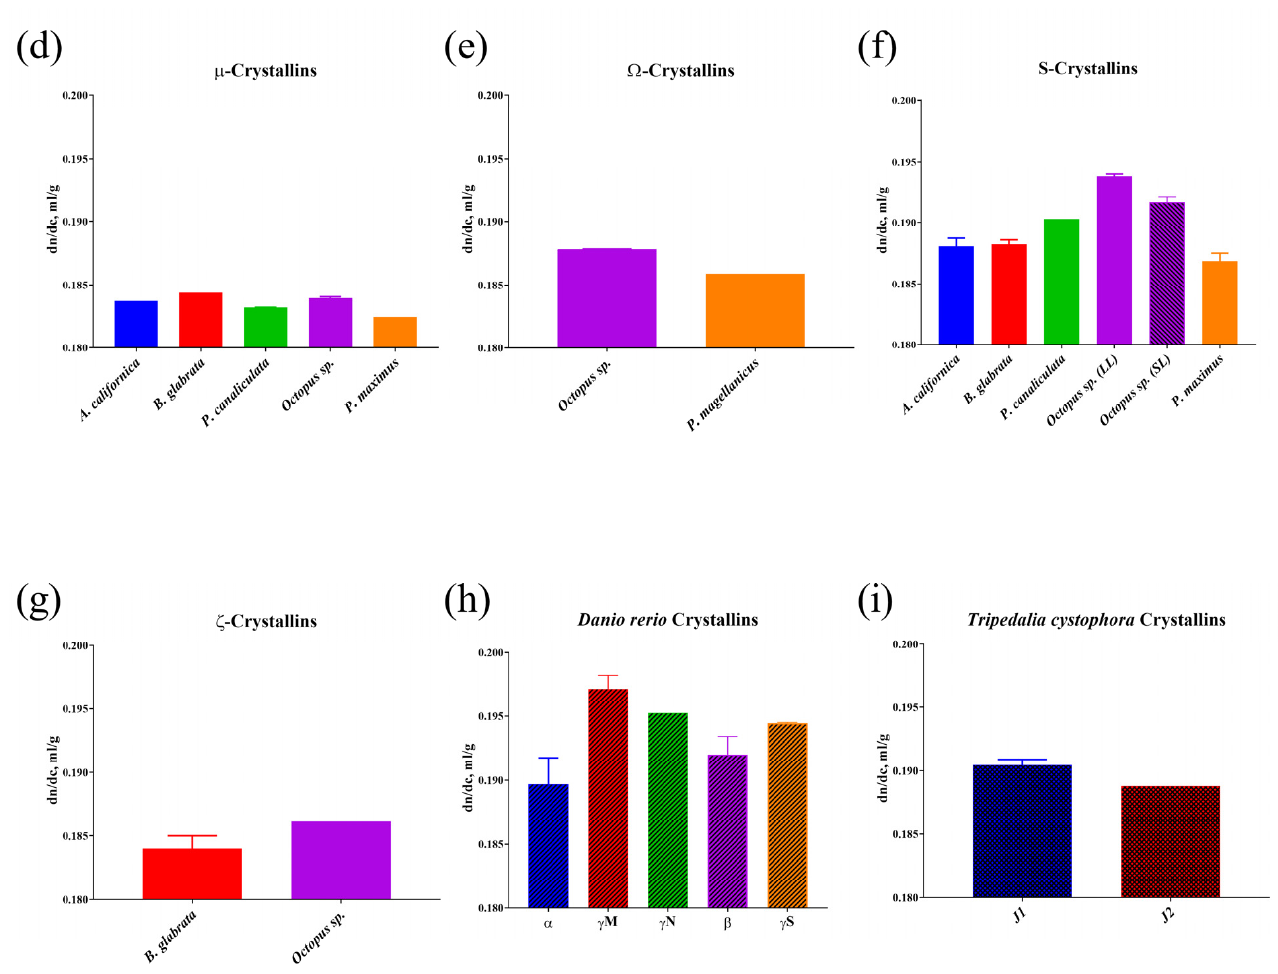
Figure 2. Calculated mean values of the increment of refractive index ( dn/dc , mL/g) for the groups of mollusc crystallins and lens crystallins of Danio rerio and Tripedalia cystophora . Data are presented as mean ± SEM (except for n = 1).